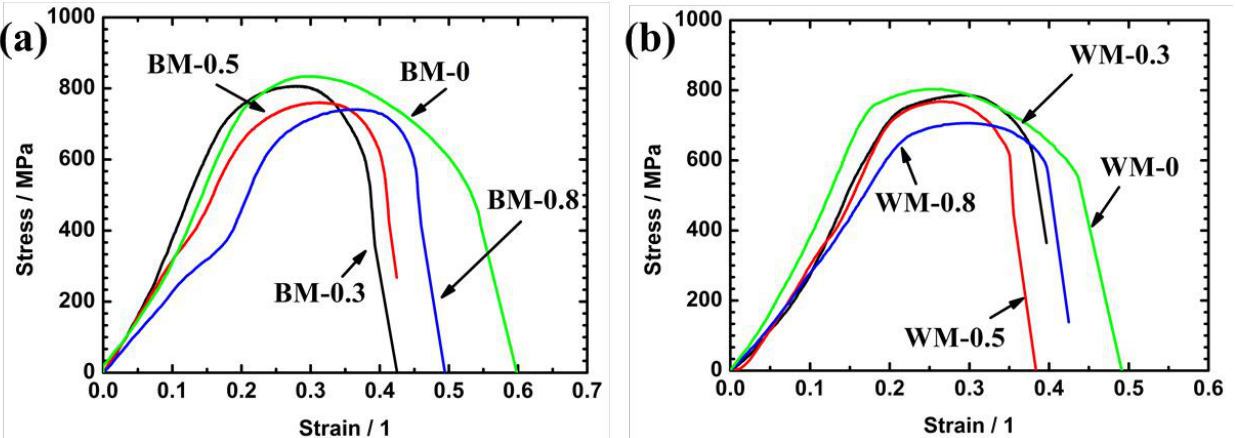
Figure 4. Tensile curves of as-received and low-cycle fatigue damaged specimens: BM ( a ) and WM ( b ). Table 2. The yield strength (YS) and ultimate tensile strength (UTS) of BM and WM acquired from the tensile curves (MPa).